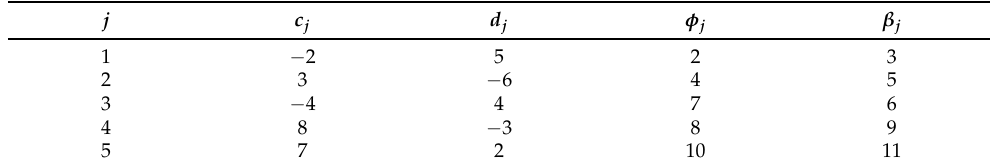
Table 1. Original parameters of the function f ( x ) in (58).